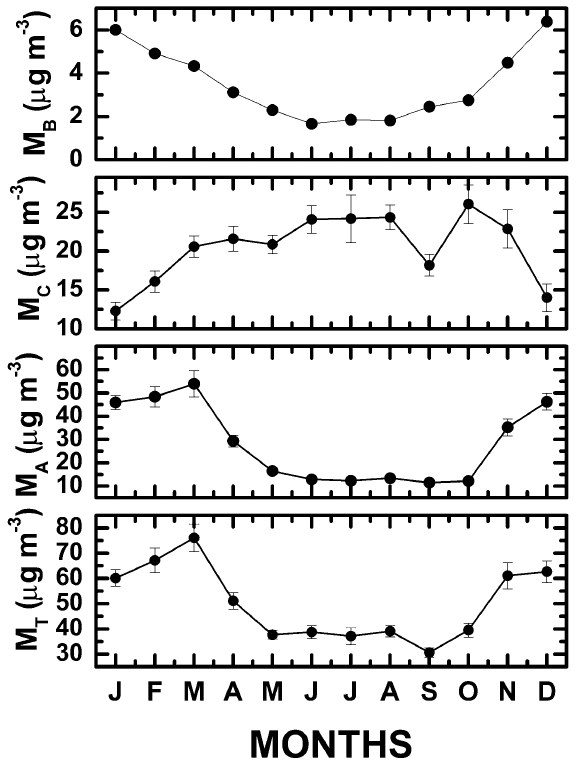
Figure 7. Annual variation of monthly mean values of total mass concentration (M T ), Fig. 7. Annual variation of monthly mean values of total mass accumulation mode mass concentration (M A ), coarse mode mass concentration (M C ) and black concentration ( M T ) , accumulation mode mass concentration ( M A ) , coarse mode mass concentration ( M C ) and black carbon mass con- carbon mass concentration (M B ) (respectively in the panels from the bottom to the top) at the centration ( M B ) (respectively in the panels from the bottom to the near surface level. The vertical line through each point represents the standard deviation of the top) at the near surface level. The vertical line through each point mean. represents the standard deviation of the mean.